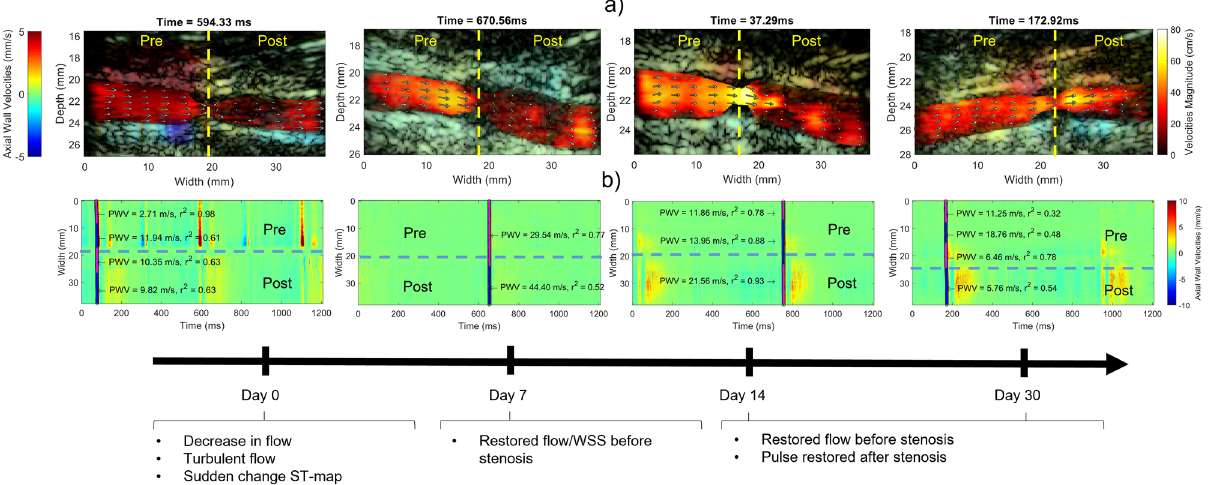
Figure 4. Qualitative example of early remodelling around the artificial ligation. ( a ) B-Mode of carotid around the artificial ligation with the wall velocity (left color bar) and flow velocity (right color bar) overlayed. Immediately after ligation the flow is reduced as indicating by a dark red color. Additionally, the pulse is obstructed, as seen by large wall velocities before the ligation and low wall velocities after the ligation. The flow has recovered in as little as 7 days, as indicated by a more yellow color indicating higher flow velocity. The pulse is not clearly visible anymore. After 14 days, the flow remains restored, and the pulse becomes more apparent again. ( b ) Spatio-temporal maps of the wall velocities. The y-axis corresponds to the position in the vessel, whereas the x-axis corresponds to the time. Similarly, as in ( a ) immediately after ligation, an obstruction in pulse propagation can be observed. The pulse is barely visible after 7 days, and becomes apparent again after 14 days. Following the ligation, the spatiotemporal map remains